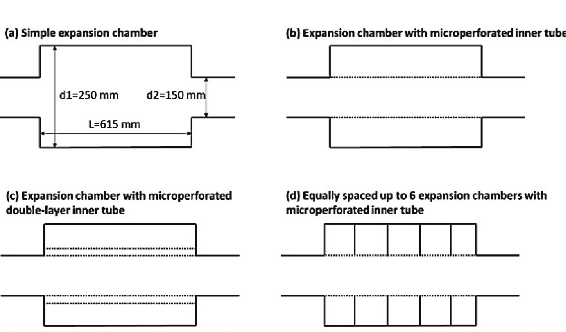
Fig. 5. Two-port measurement set-up for the determination of acoustic transmission loss. Fig. 6. Various silencer layout concepts used in the